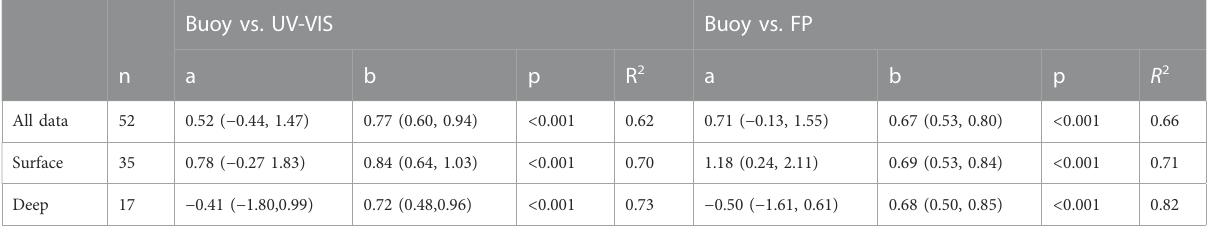
TABLE 1 Results from linear regressions between chlorophyll- a concentrations measured by in-situ sensors (buoy) and by UV-VIS spectrophotometry or FluoroProbe(FP).Theintercept(a),slope(b),coef fi cientofdetermination( R 2 ),and p -valuesarereported;lowerandupper95%con fi denceintervalsofaandb are reported in brackets.